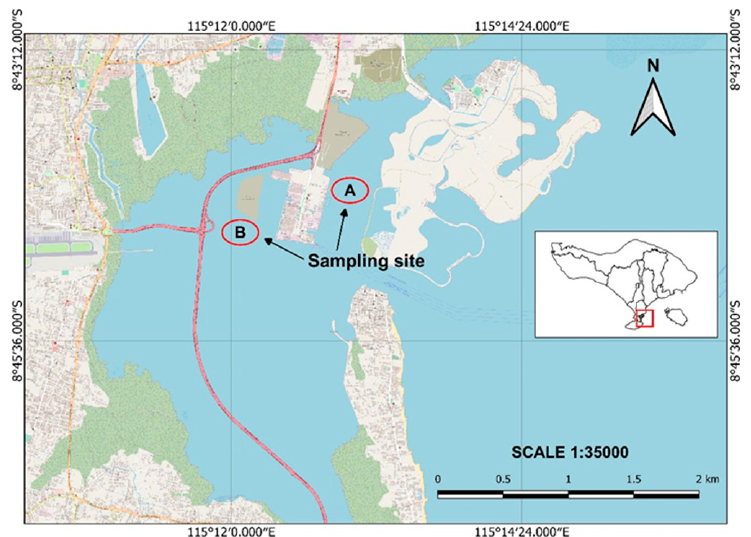
Figure 6. Map of sampling sites. (A: sampling site of Bulung Anggur; B: sampling site of Bulung Boni).